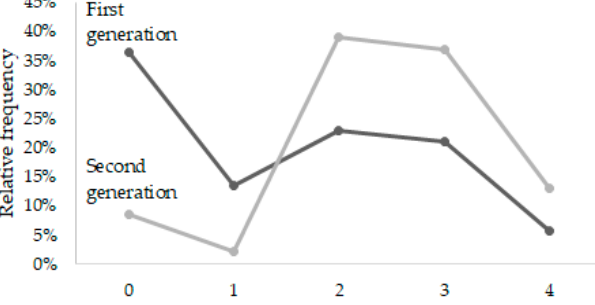
Figure 7. Interaction plot of the relative frequencies of the number of types of introduced innovation grouped by the generation running the family business.